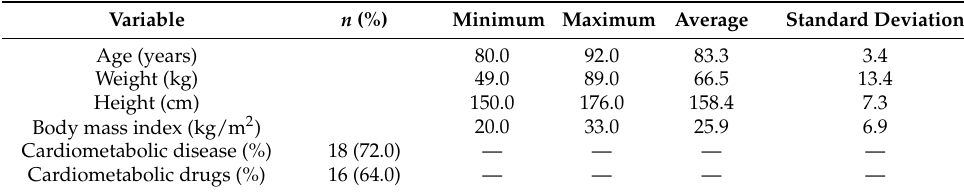
Table 1. Characteristics ( n = 25) of the octogenarian